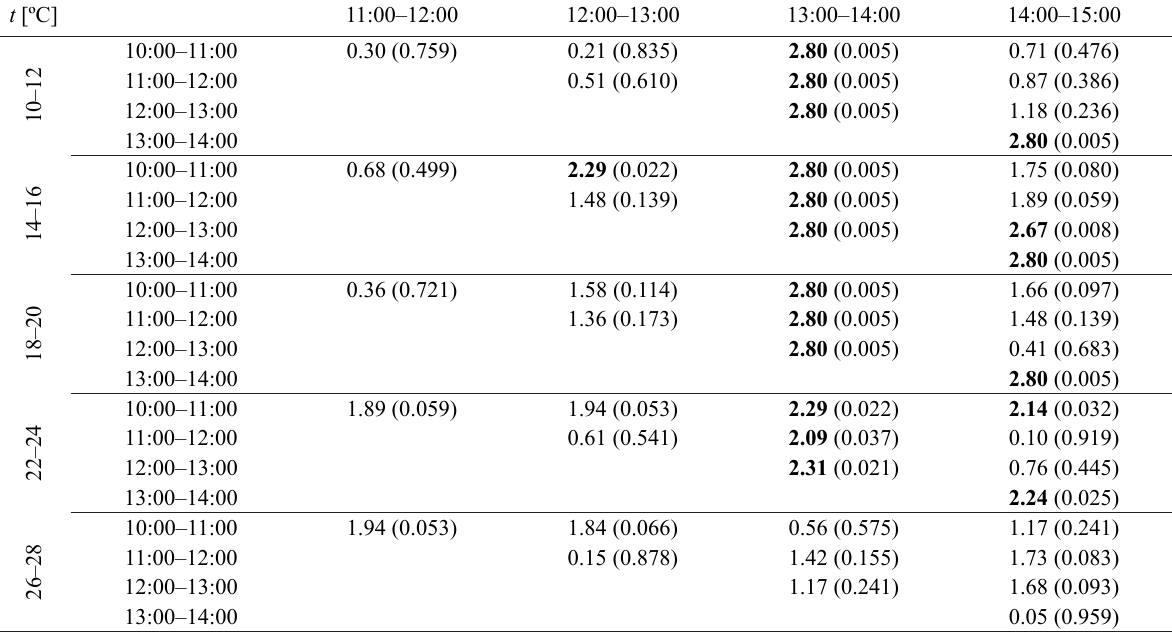
Matrices of Mann–Whitney U -test parameters for comparing the activity (mean number of movements per hour) of round goby, Neogobius melanostomus , during one hour with normal atmospheric pressure (10:00–11:00 h, 13:00– 15:00 h) and with the atmospheric pressure decreased by 1333 Pa (11:00–13:00 h)